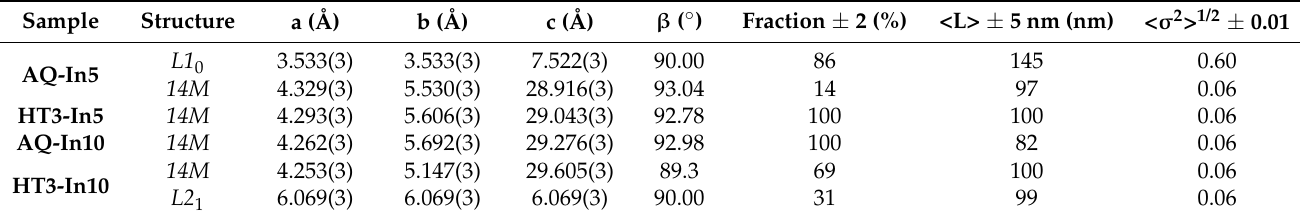
Figure 3. Illustration of monoclinic 14M ( a ) and tetragonal L1 0 ( b ) crystal structures. Table 1. Structure, lattice parameters (a, b, c), β angle, average crystallite size, <L>, microstrains, < σ 2 > 1/2 , and relative fraction of AQ-In5, AQ-In10, HT3-In5, and HT3-In10 ribbons. Sample